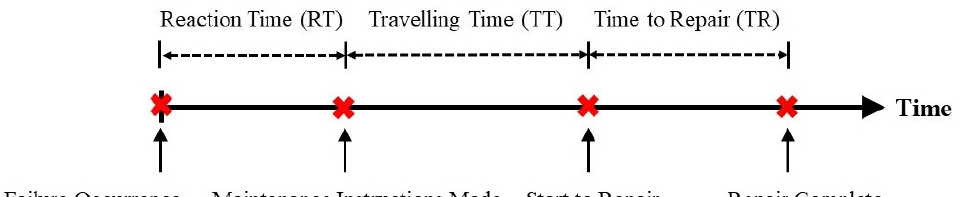
Figure 8. RT, TT, and TR of wind turbines.